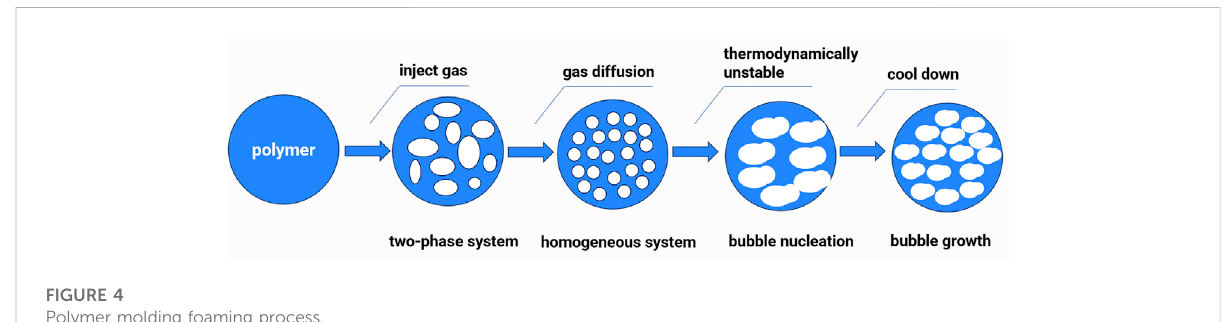
FIGURE 4 Polymer molding foaming